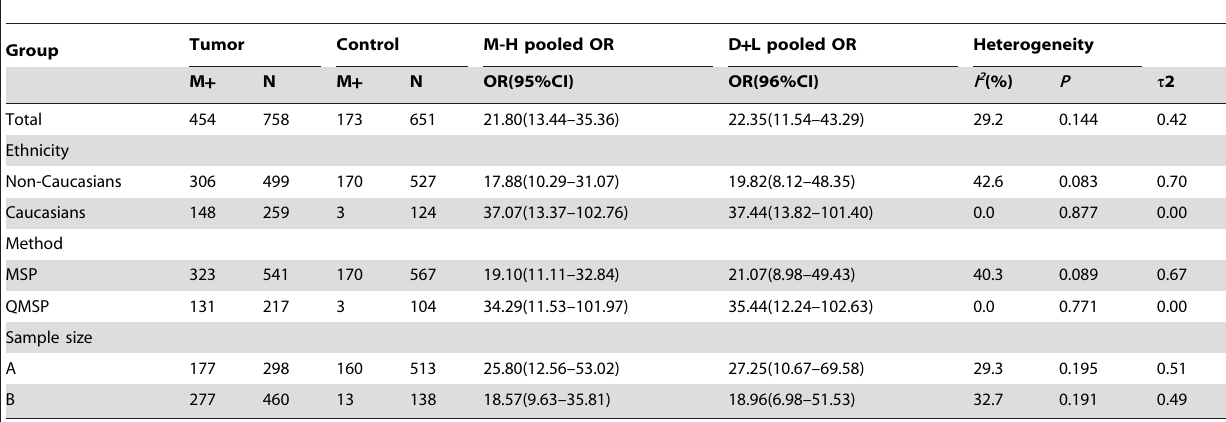
Table 5. Subgroup meta-analysis of the association between DAPK1 promoter methylation and cervical cancer omitting one heterogeneous study (Yang et al.).